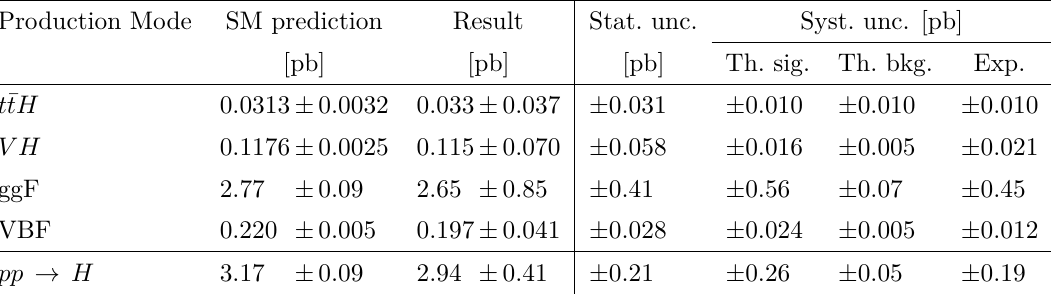
Table 14. Best-fit values and uncertainties for the pp → H → ττ cross-section measurement and the measurement in the four dominant production modes. All measurements include the branching ratio of H → ττ and refers to true Higgs boson rapidity | y | < 2 . 5 . The SM predictions for each region, H computed using the inclusive cross-section calculations and the simulated event samples are also shown. The contributions to the total uncertainty in the measurements from statistical (Stat. unc.) or systematic uncertainties (Syst. unc.) in the signal prediction (Th. sig.), background prediction (Th. bkg.), and in experimental performance (Exp.) are given separately. Each uncertainty is reported as the average of its upward and downward fluctuations. The total systematic uncertainty, equal to the difference in quadrature between the total uncertainty and the statistical uncertainty, differs from the sum in quadrature of the Th. sig., Th. bkg., and Exp. systematic uncertainties due to correlations. STXS bin SM prediction Result